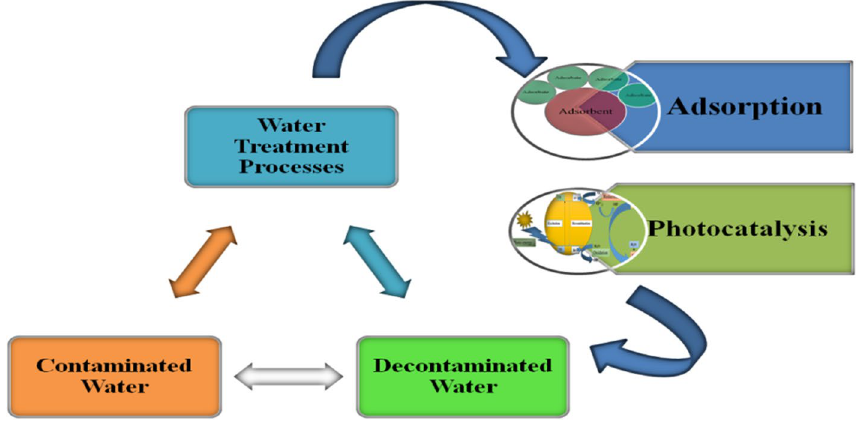
Fig. 1 Graphical abstract show- ing the decontamination of water by using adsorption and photocatalysis